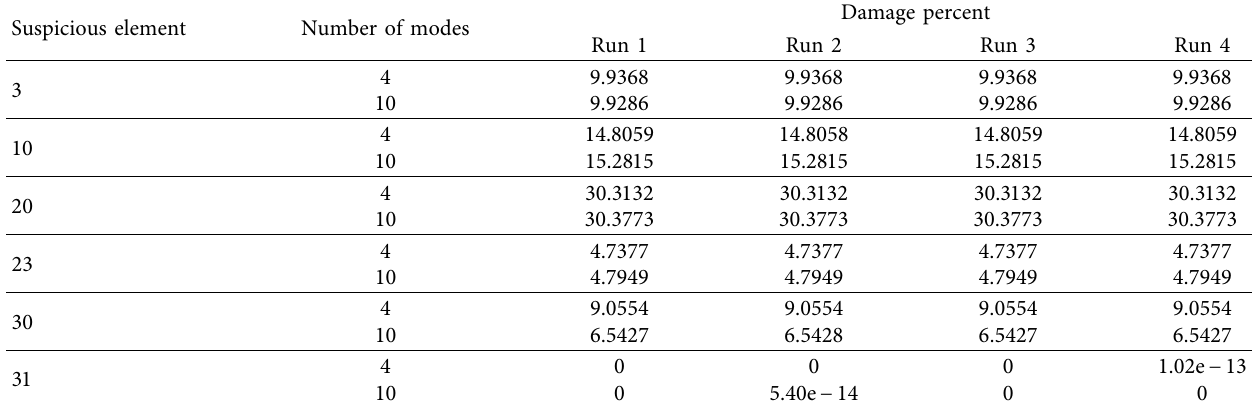
Figure 7: Frame. Table 4: Damage detection results of step 2 for the 35-element planar truss, 4%